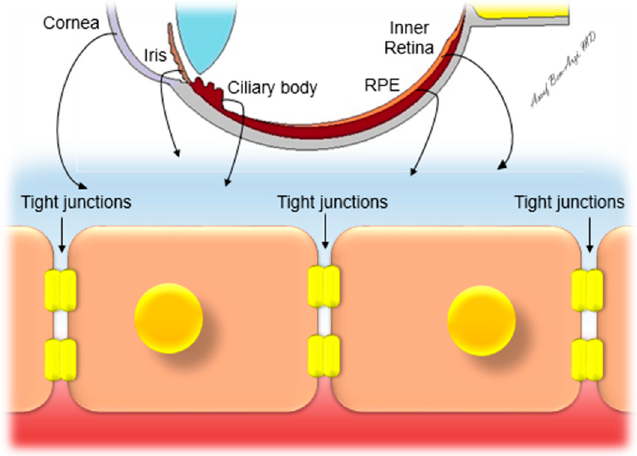
Figure 1. The various ocular barriers with tight